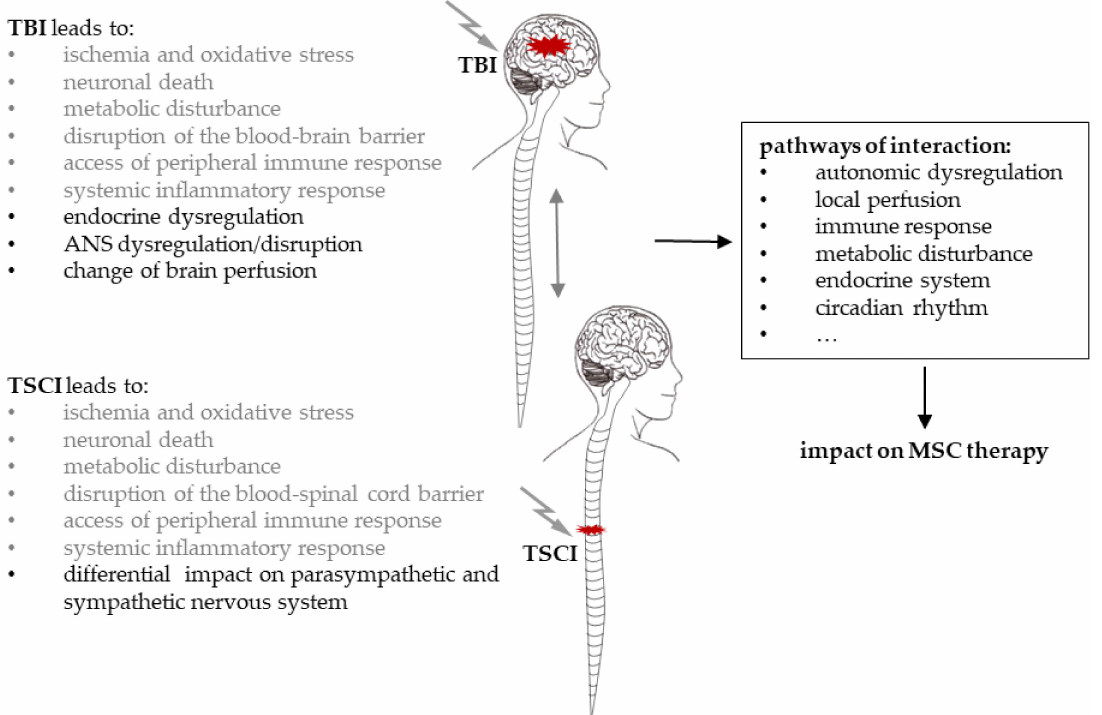
Figure 5. Interactive response of TSCI and TBI potentially effecting MSC treatment. Although TSCI and TBI feature common local and systemic effects (grey), several responses to spinal cord and brain injury are unique (black). Therefore, different pathways of interaction can be identified and should be considered in order to optimise mesenchymal stem cell (MSC) treatment in patients suffering from TSCI with concomitant TBI. Abbreviations: ANS = autonomous nervous system, TBI = traumatic brain injury, TSCI = traumatic spinal cord